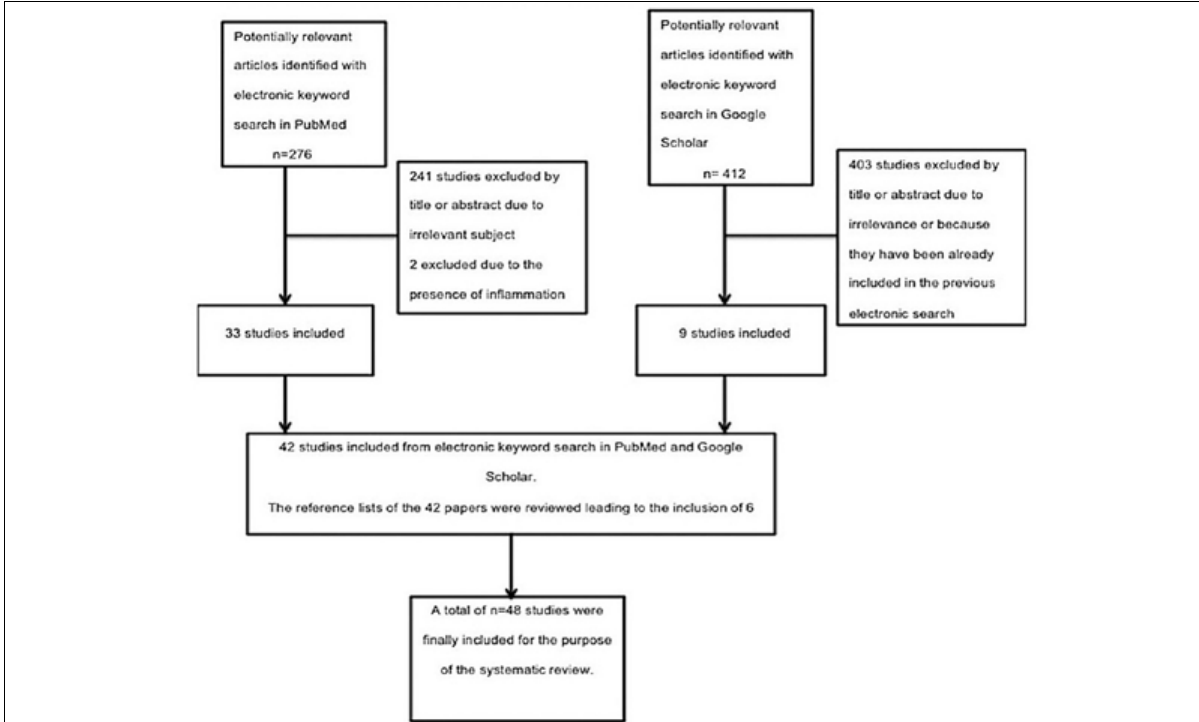
Figure 1. The flow diagram demonstrates the strategy used for the selection of studies for this